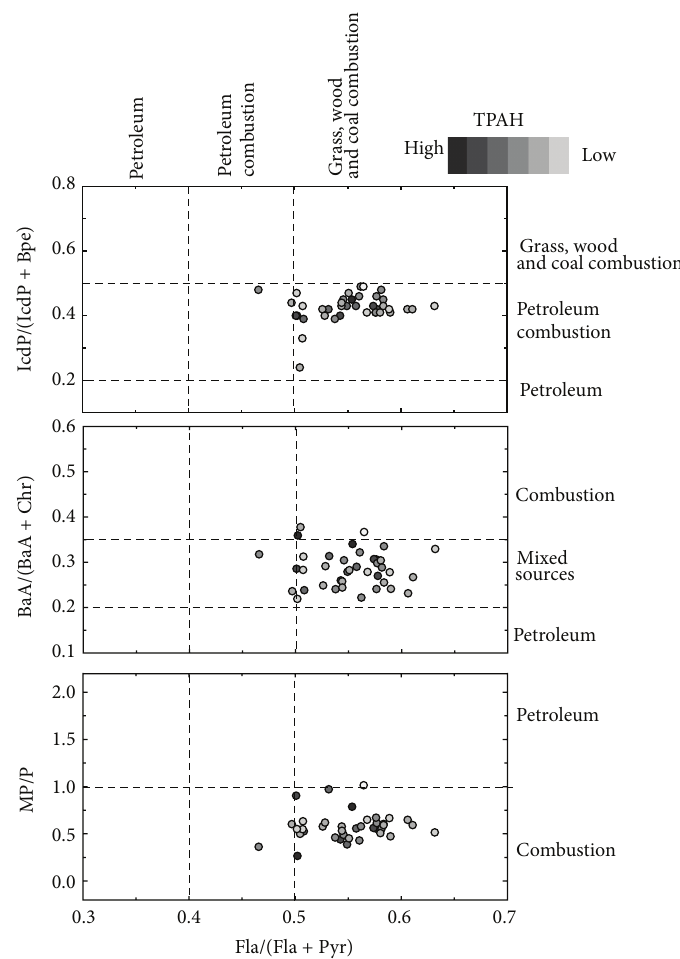
Figure 2: Cross plot of PAHs based on different diagnostic ratios for surface sediments from the Yellow River-dominated continental margin. (a) IcdP/(IcdP + Bpe) versus Fla/(Fla + Pyr); (b) BaA/(BaA + Chr) versus Fla/(Fla + Pyr); (c) MP/P versus Fla/(Fla + Pyr). IcdP: indeno[1,2,3- cd]pyrene; Bpe: benzo[g,h,i]perylene; Fla: fluoranthene; Pyr: pyrene; BaA: benz[a]anthracene; Chr: chrysene; MP: methyl phenanthrenes; P: phenanthrenes. The dash lines represent the thresholds for different sources